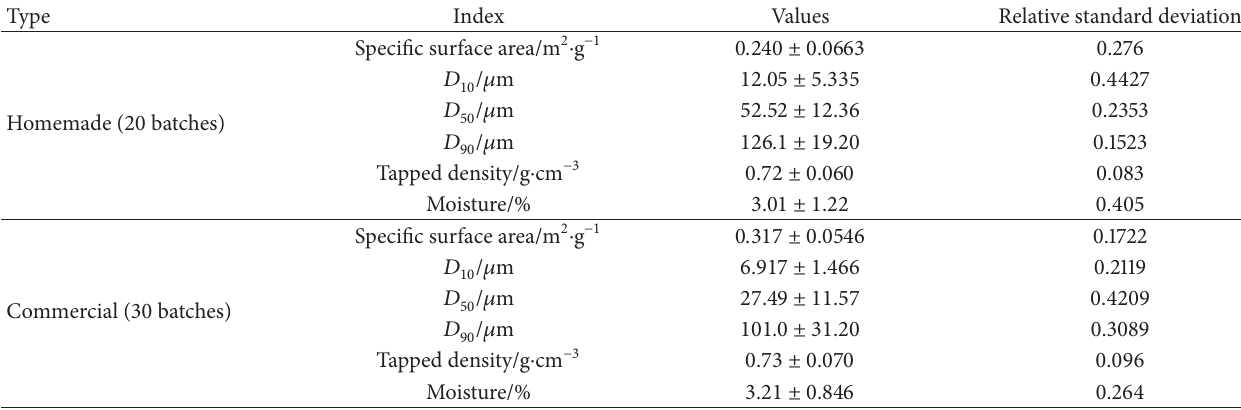
Table 4: Results of physical attributes tests of tanshinone extract powders.